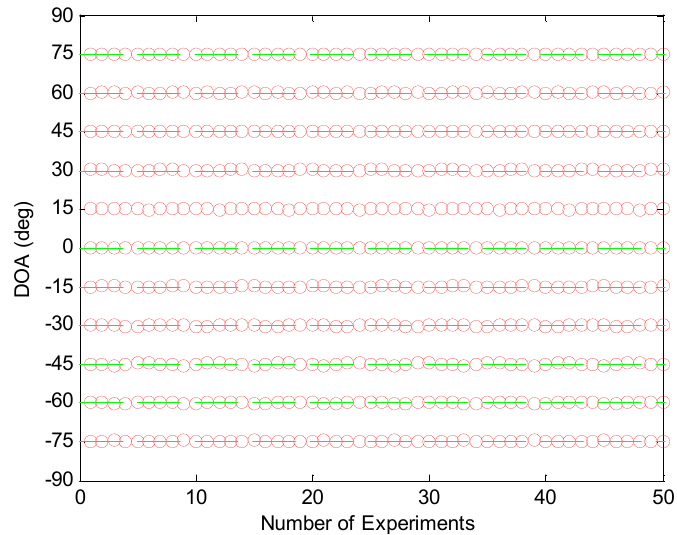
Figure 3. Resolution ability test of the proposed method in different trials; first example.